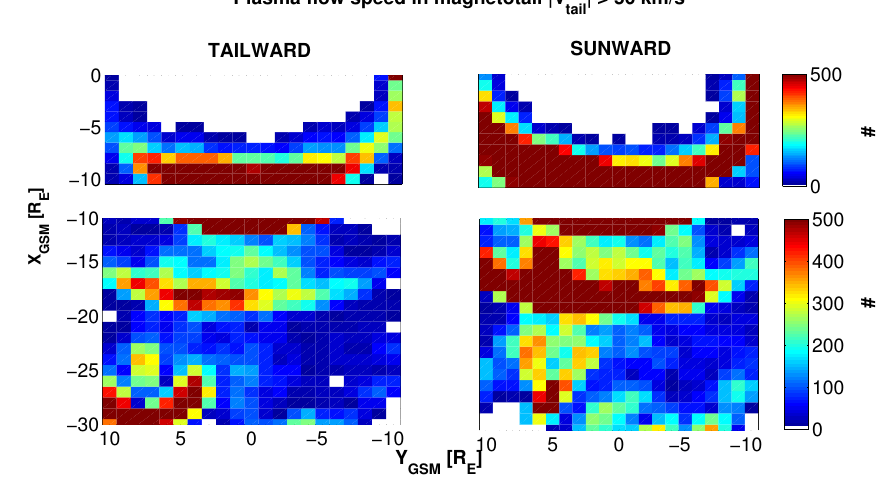
around it. This area also features weaker net plasma flow in the maps of an average flow speed of > 50 km s − 1 . The weakening of the sunward flows in the area may be related to the formation of the reconnection line. The tailward net flow does not show large changes during different B Z conditions, but this may also be because of the limited data set during the positive B Z . Instead, the tailward net flow pattern for slow flows ( | V tail | < 50 km s − 1 ) shows clear differences during dif- ferent IMF B Z times (Fig. 7, the top-right panels). The aver- age flow is slower when B Z is